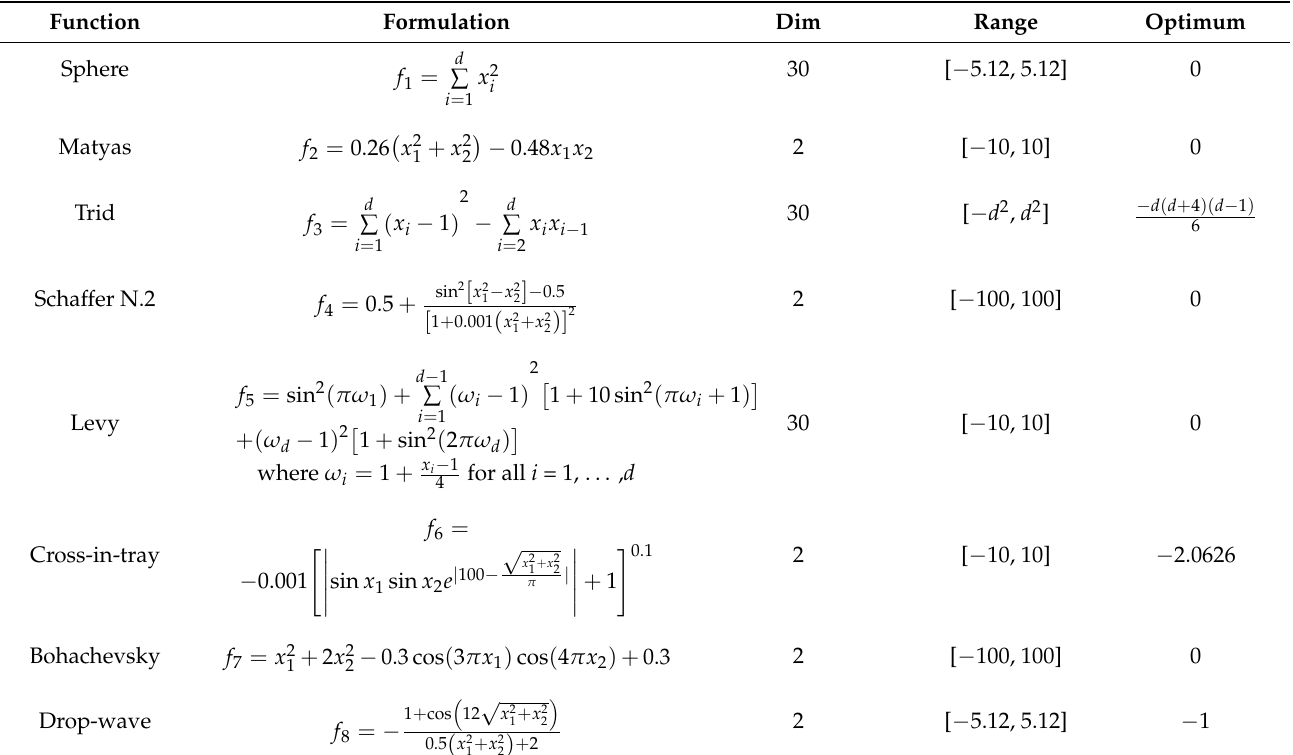
Table 4. Benchmark functions.